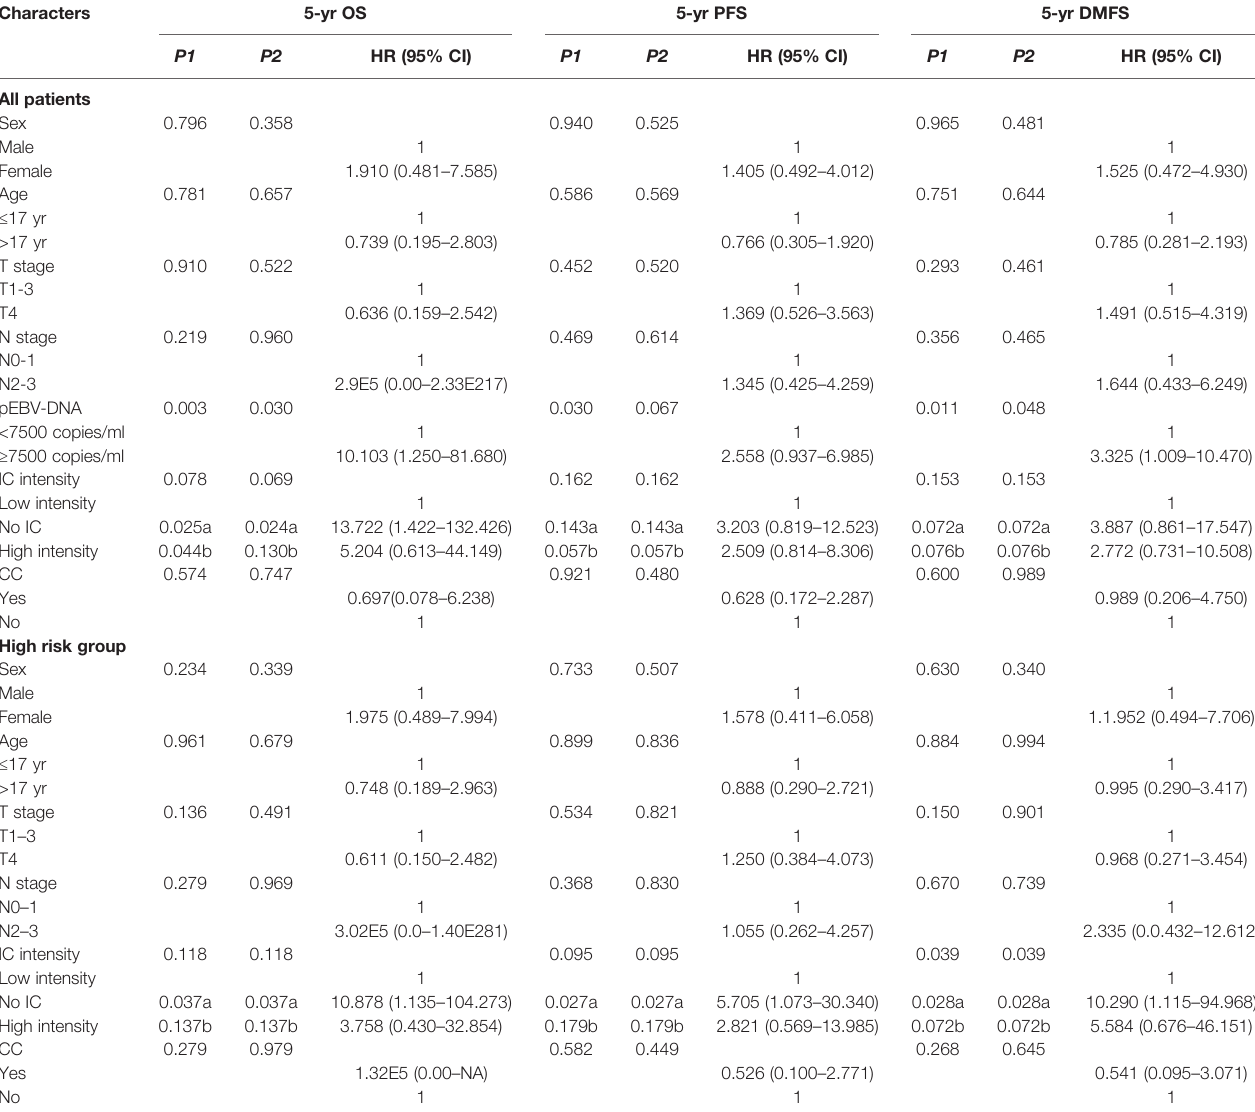
TABLE 2 | Univariate and multivariate analysis for potential prognostic factors in clinical outcomes among all patients and patients in the high risk group. Characters 5-yr OS 5-yr PFS